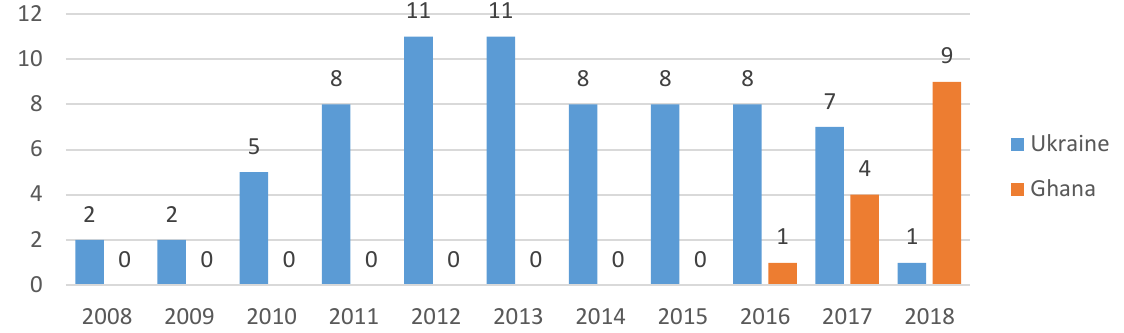
Figure 1. Number of SR in Ghana and Ukraine for the period of